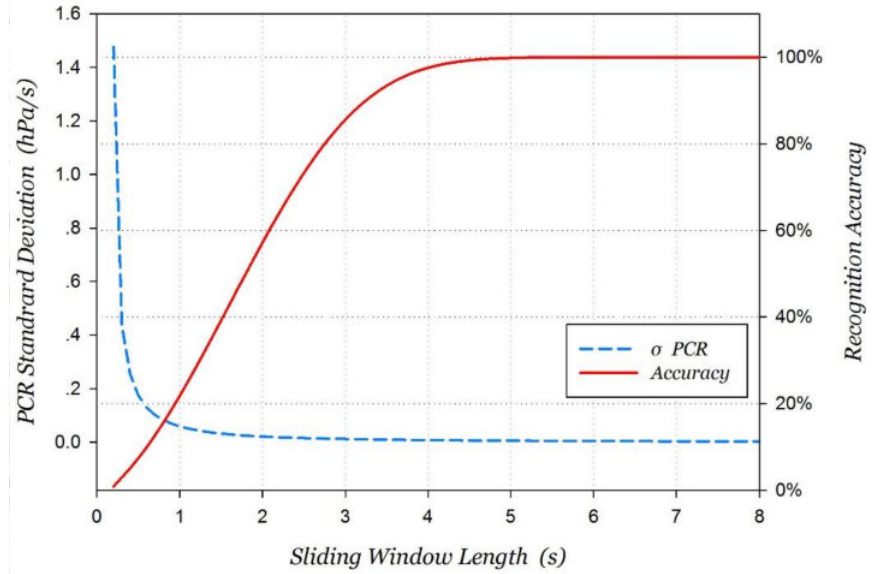
Figure 3. Recognition accuracy of the upper and lower moving states with sliding window